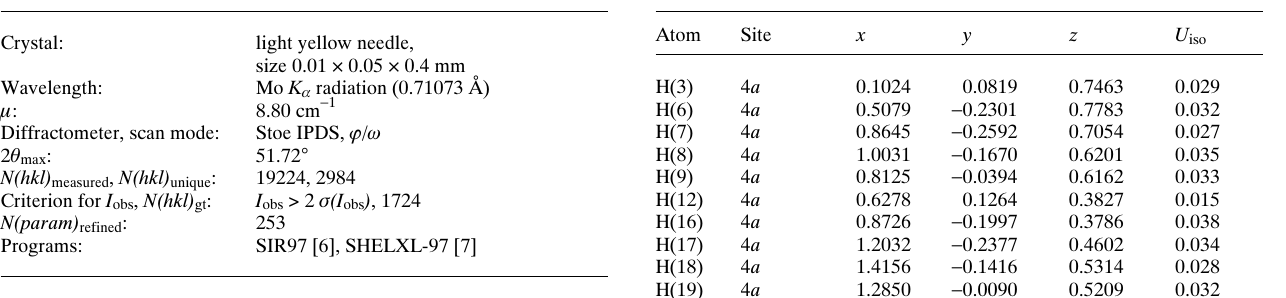
Table 2. Atomic coordinates and displacement parameters (in Å 2 ) . Table 1. Data collection and